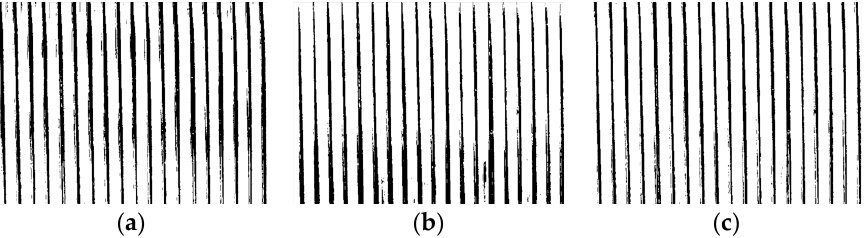
Figure 10. Compare different binary images: ( a ) adaptive binarization, ( b ) the original image is obtained as a binarized image based on the above threshold, ( c ) the slice method grayscale map is based on the binarized image obtained from the above threshold.